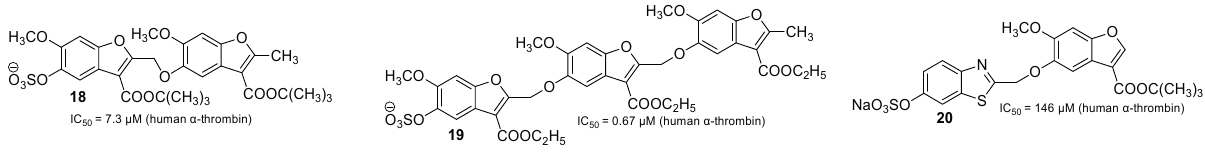
Figure 4. The chemical structures of allosteric thrombin